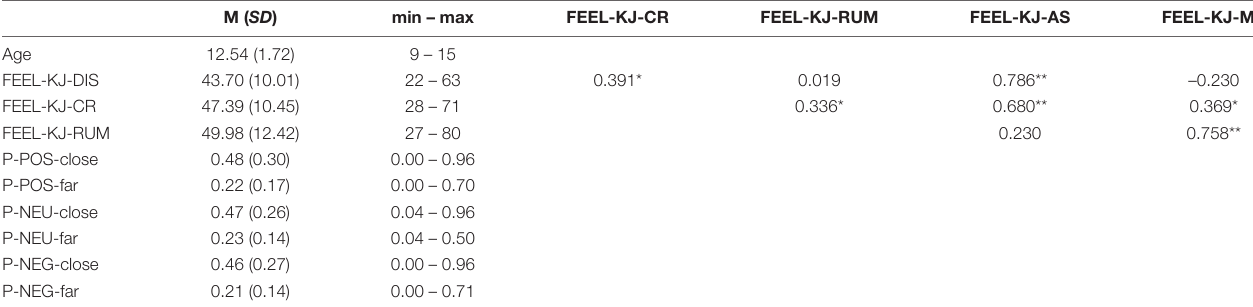
TABLE 2 | Descriptive statistics and bivariate correlations in the final